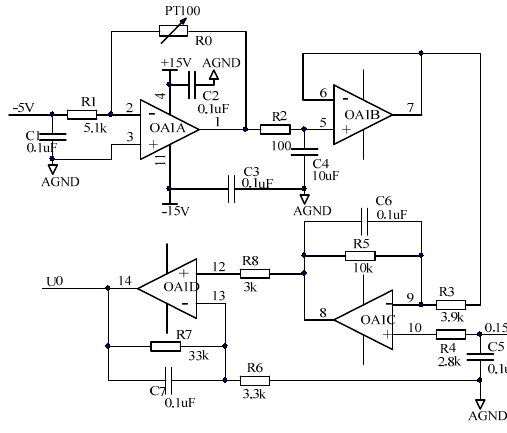
Figure 23. Schematic circuit for resistance-to-voltage